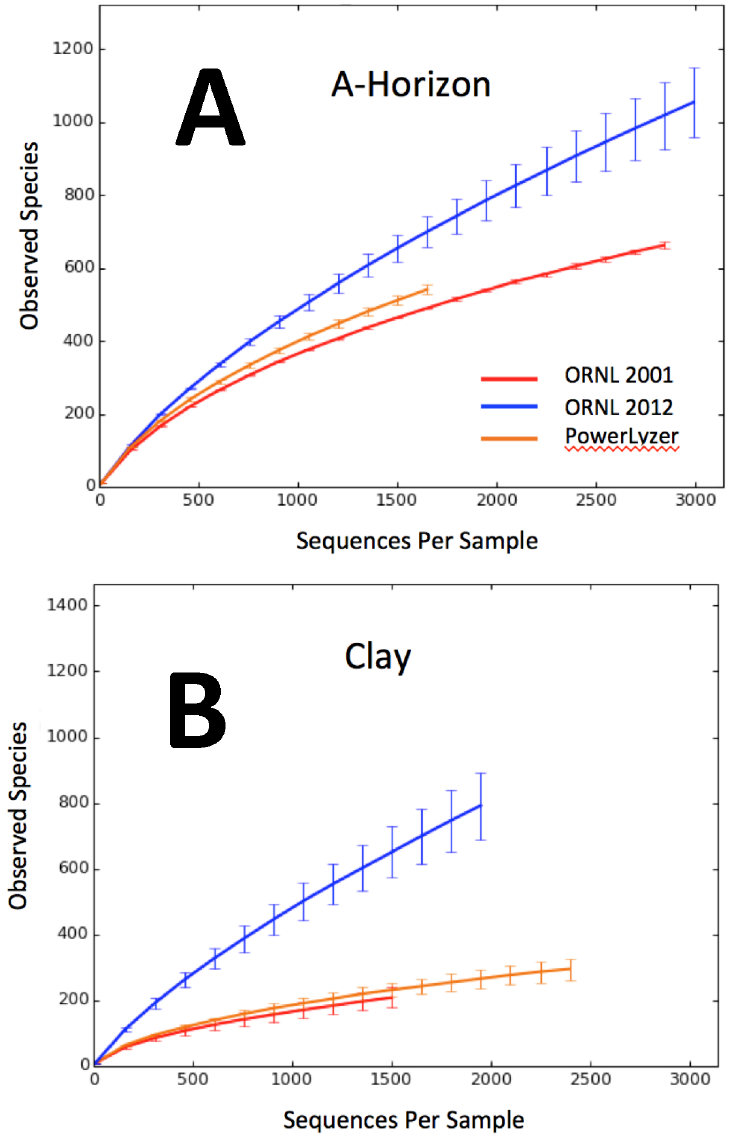
Figure 5. Rarefaction based comparison of Extraction Procedures. Rarefaction analysis was performed using the de-noised 454 pyrotag sequencing data on de novo picked OTUs for ( A ) A-horizon and ( B ) clay samples. Each curve is the average from experimental replicates (N=2 libraries for the 2001 method and ORNL 2012 method A-horizon samples; N=3 libraries for the remainder of the sample/method combinations) from 100 jackknife iterations over each sampling depth. The key for the A-horizon comparison of accessed diversity uses the same color code as for the clay sample comparison.